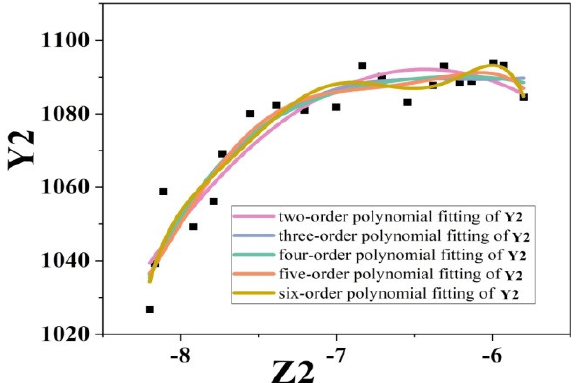
Table 3. The error of different multi-order polynomial for EGT 1 . Figure 3. Five different polynomial fitting curves for RPM (Z) and EGT2 (Y2). Figure 3. Five different polynomial fitting curves for RPM (Z) and EGT2